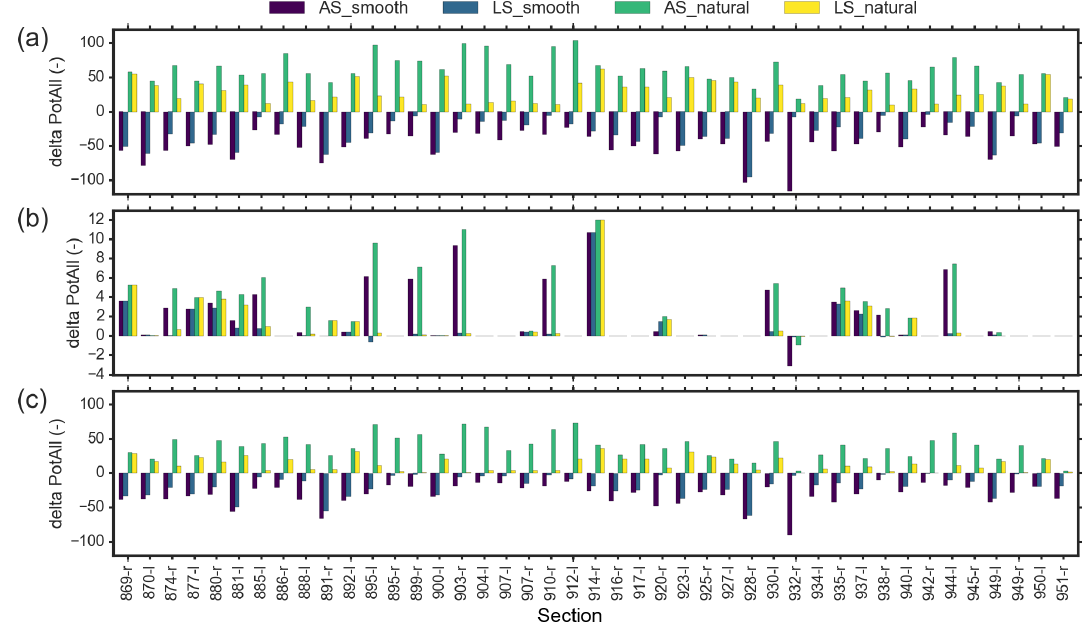
Figure 7. Changes in PotAll scores per floodplain section for three measure types: (a) smoothing (roughness lowering), (b) side channels, and (c) floodplain lowering. Note the different vertical scale in panel (b) .